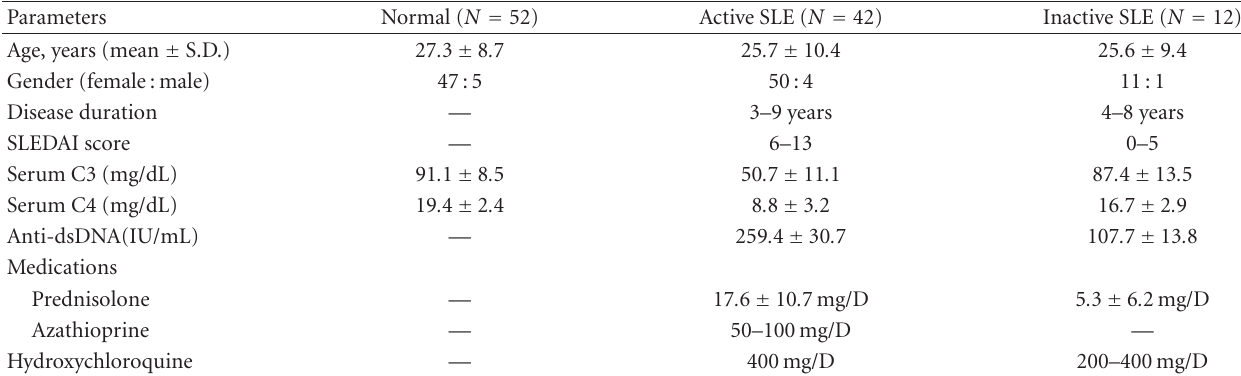
Table 1: The demographic features and clinical data of normal, active, and inactive SLE